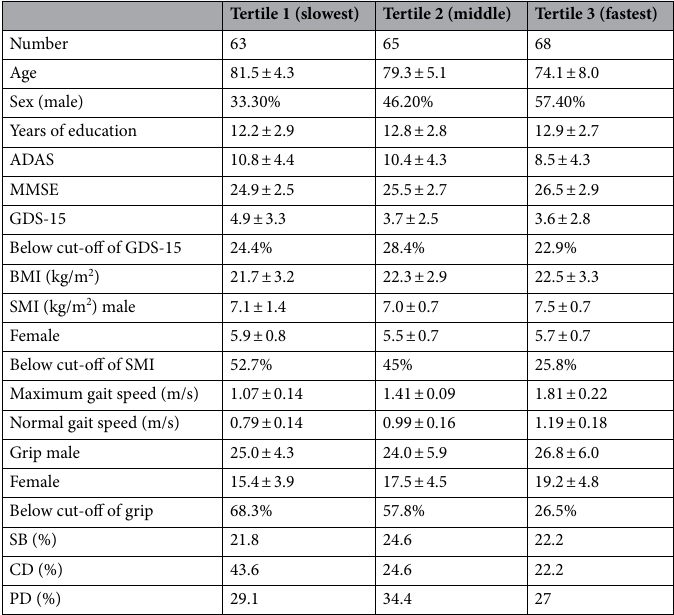
Table 2. Characteristics of participants in tertiles of maximum gait speed. Mean ± Standard deviation was shown. Cut-off point for GDS-15 was 5/6. Cut-off point for handgrip strength of < 28 kg for men and < 18 kg for women; cut-off for low SMI was < 7.0 kg/m 2 in men and < 5.7 kg/m 2 in women. ADAS Alzheimer’s disease assessment scale, MMSE mini mental state examination, GDS geriatric depression scale, BMI body mass index, SMI skeletal muscle mass index, SB stimulus bound, CD conceptual deficits, PD planning